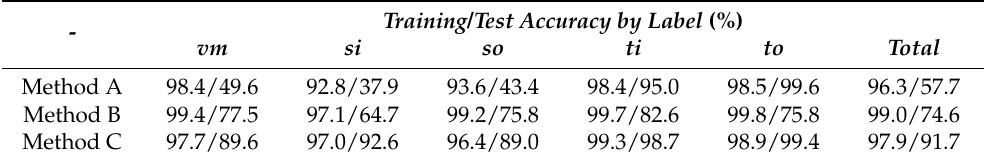
Table 4. Comparison of training and test accuracy of the floating body-fixed frame method over methods A and B with the bi-directional LSTM